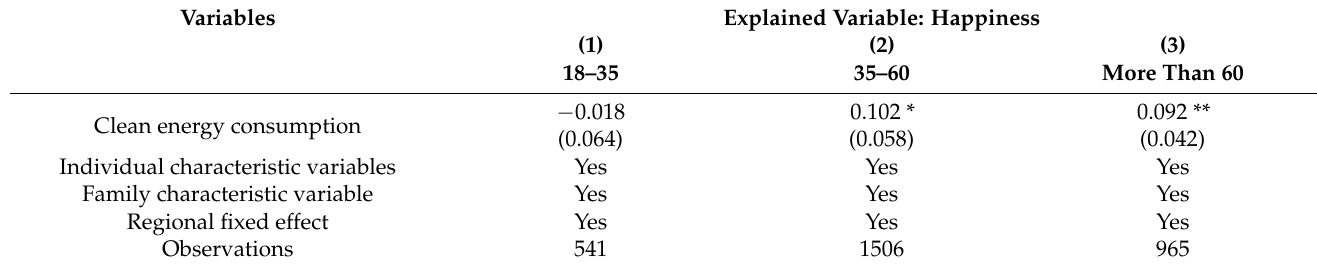
Table 7. Heterogeneity analysis from the perspectives of age.